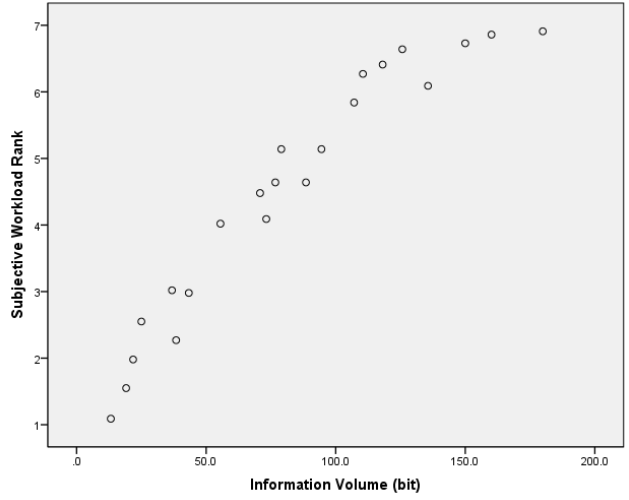
Figure 3. The correlation between objective information and subjective score.